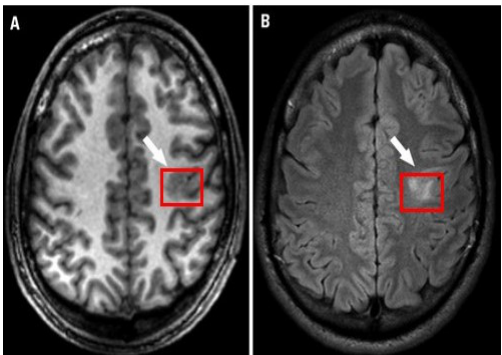
Figure 1. Focal cortical dysplasia lesion ( A ) T1-weighted MRI and ( B ) FLAIR MRI [10].